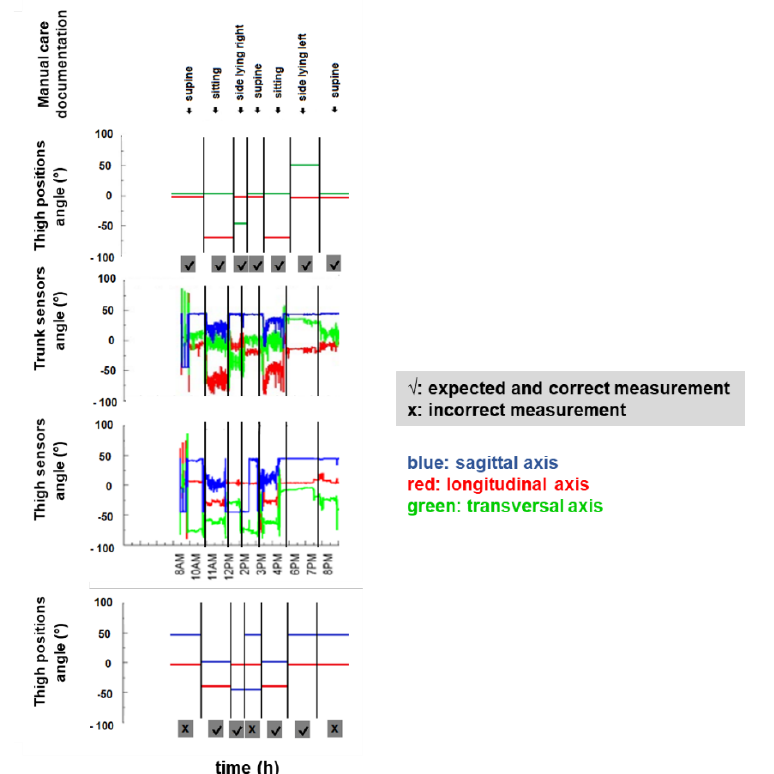
Figure 8. Accelerometric data acquisition from trunk and thigh sensor . Trunk sensors detected all position changes according to the manual care documentation and accurately distinguished supine from side-lying right/left or from a sitting position, while the thigh sensors did not detect supine position as indicated.